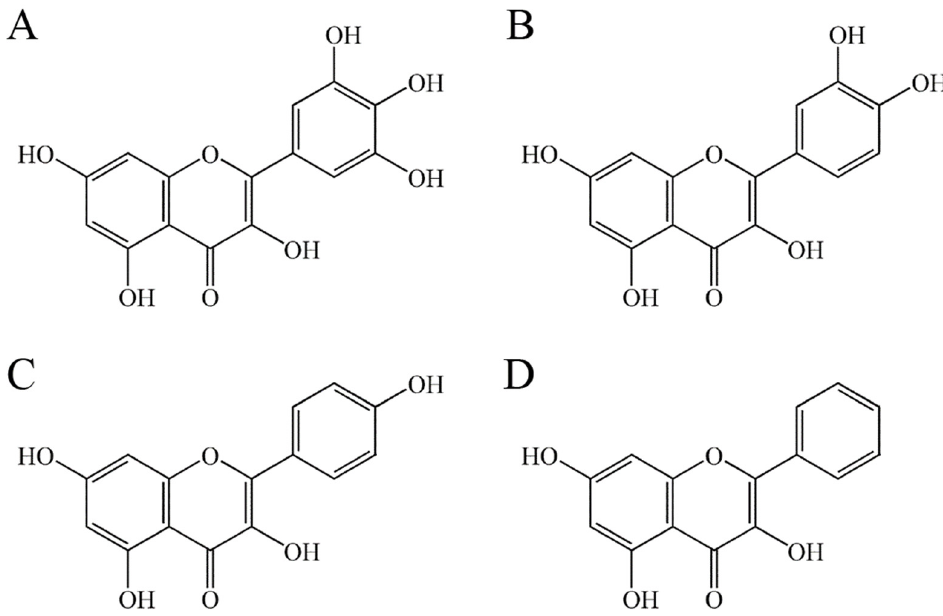
Figure 1. Molecular structure of ( A ) myricetin, ( B ) quercetin, ( C ) kaempferol, and ( D ) galangin.